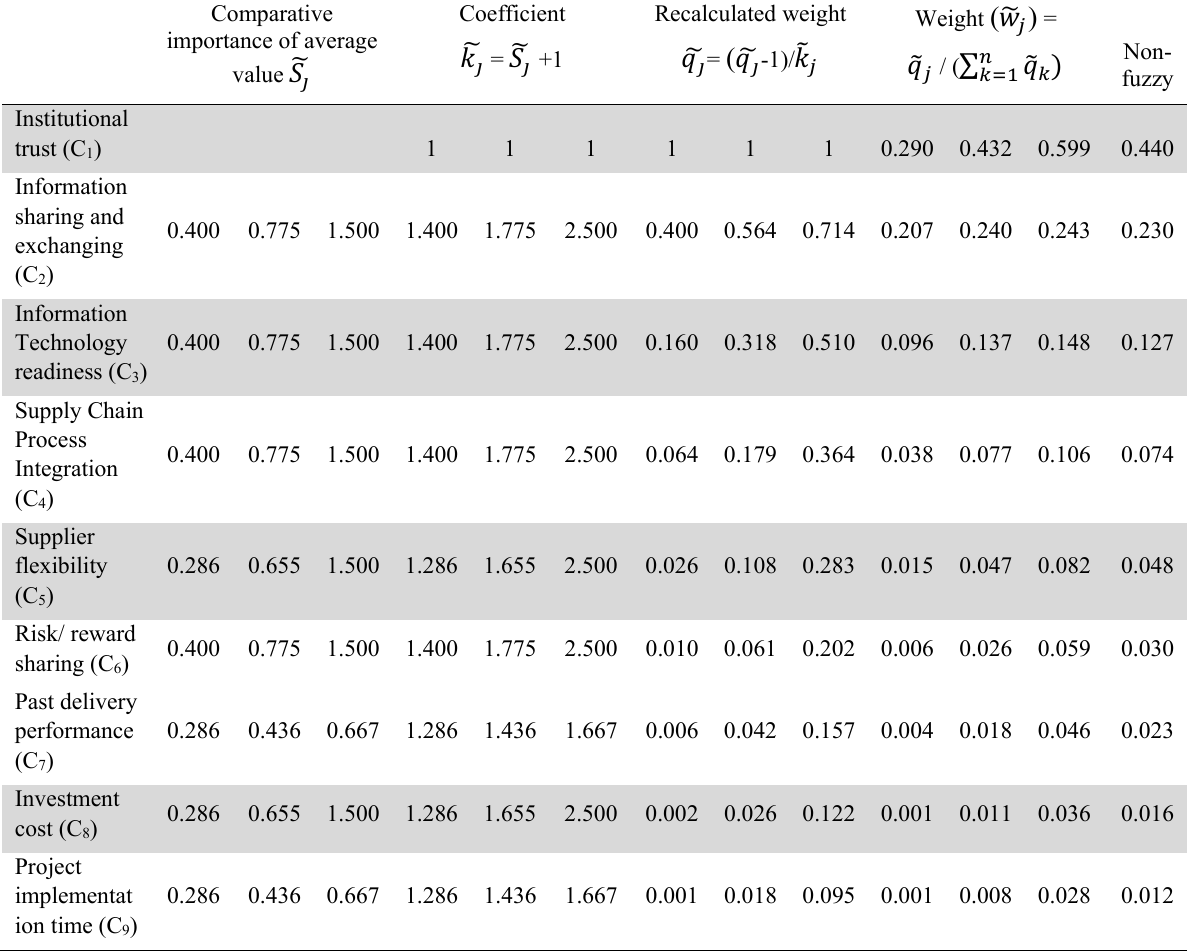
The relative importance weight of main criteria with SWARA method